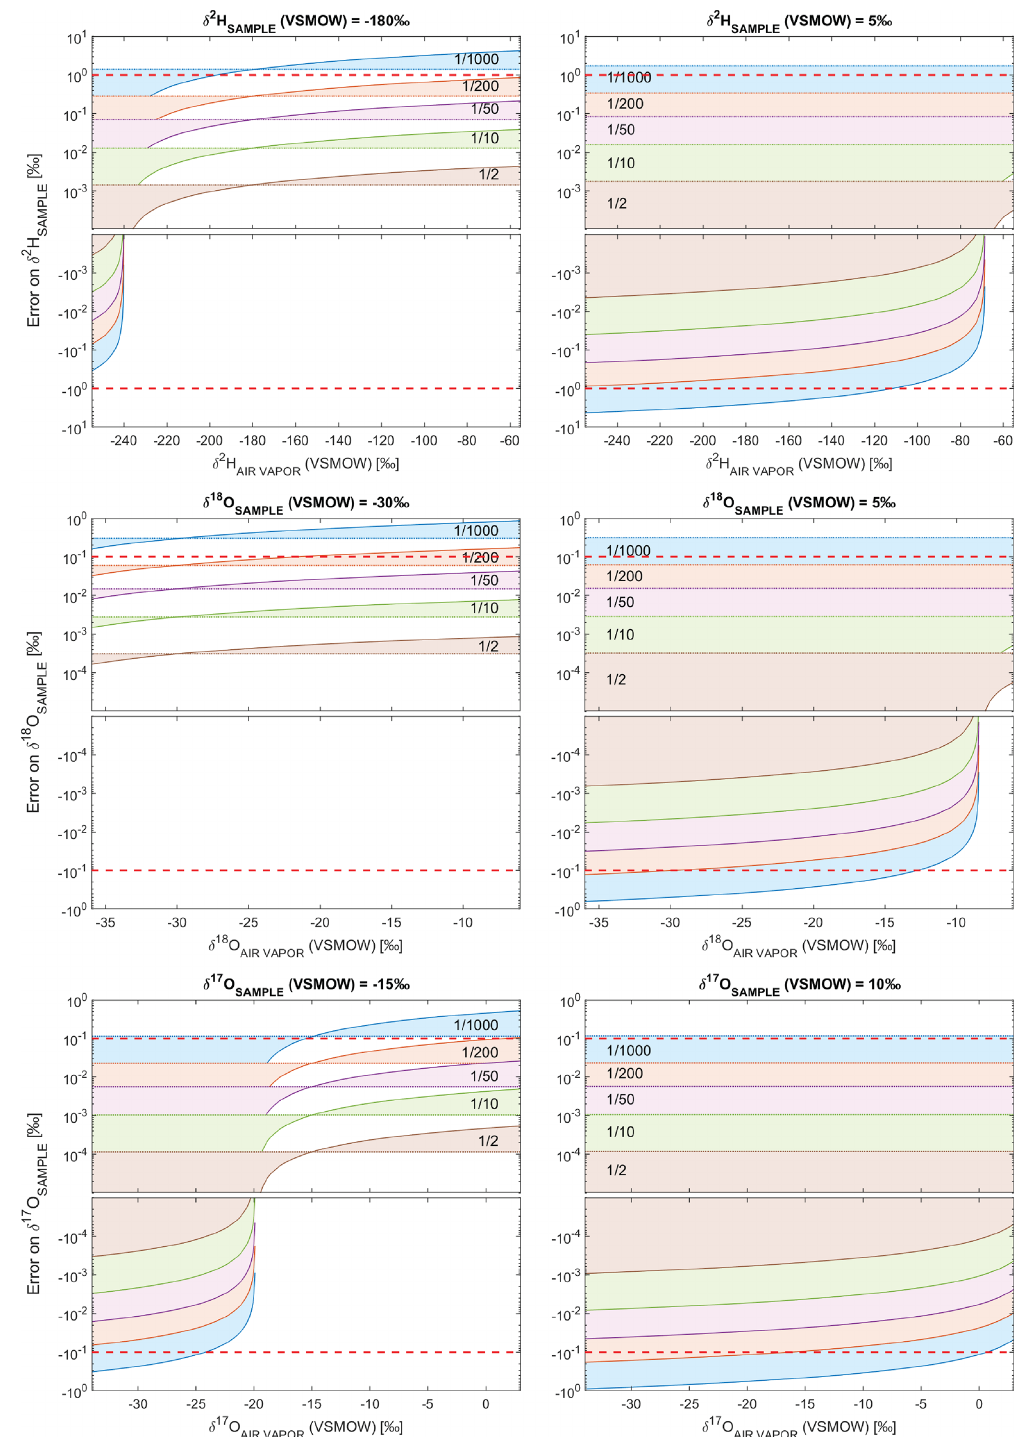
Figure A1. Changes in δ 2 H, δ 17 O, and δ 18 O of a water sample, depending on the initial isotopic composition of the water vapor of the air locked up with the sample. The results are completed for saturated air (continuous line) and dry air (dashed line), for ratios of sample volume over container volume from 1 / 2 to 1 / 1000. The dashed red line represents the detection limit of the measuring device.